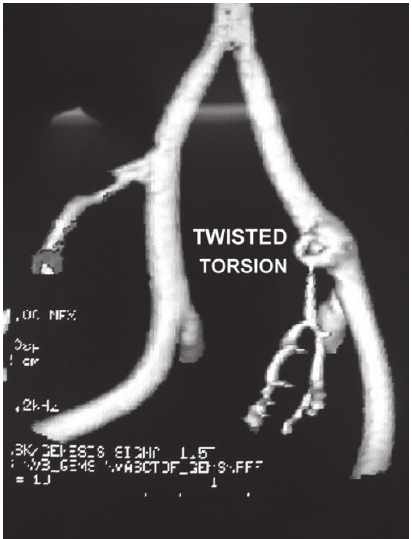
Figure 2 - Magnetic resonance angiography showing the main renal artery of the graft